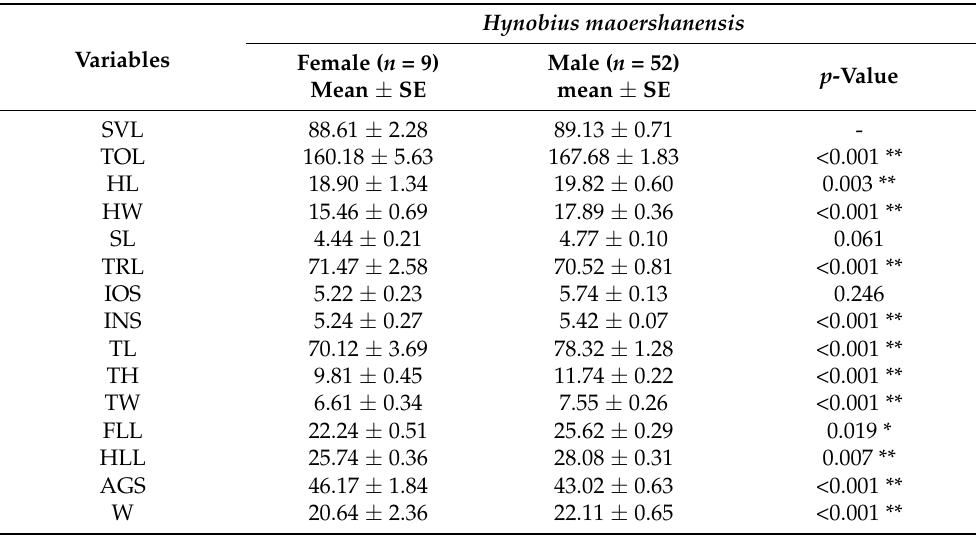
Table 2. Descriptive statistics for original morphometric variables (mm/g) in female and male H. maoershanensis